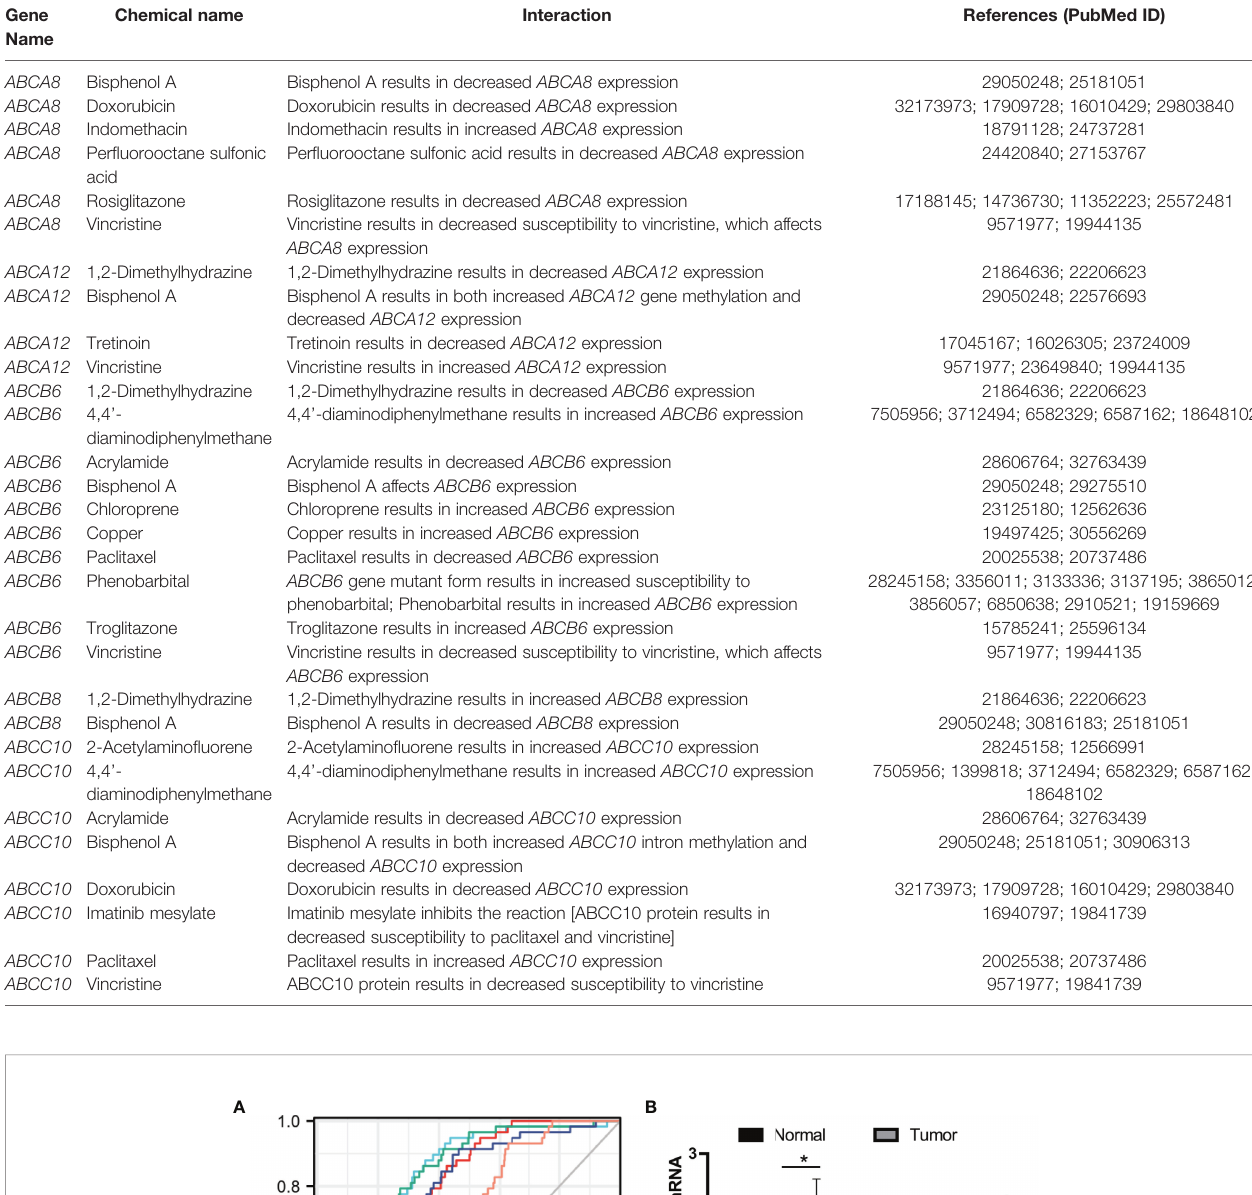
TABLE 5 | Inferred correlation between hallmark ABC transporters and chemicals in TC.